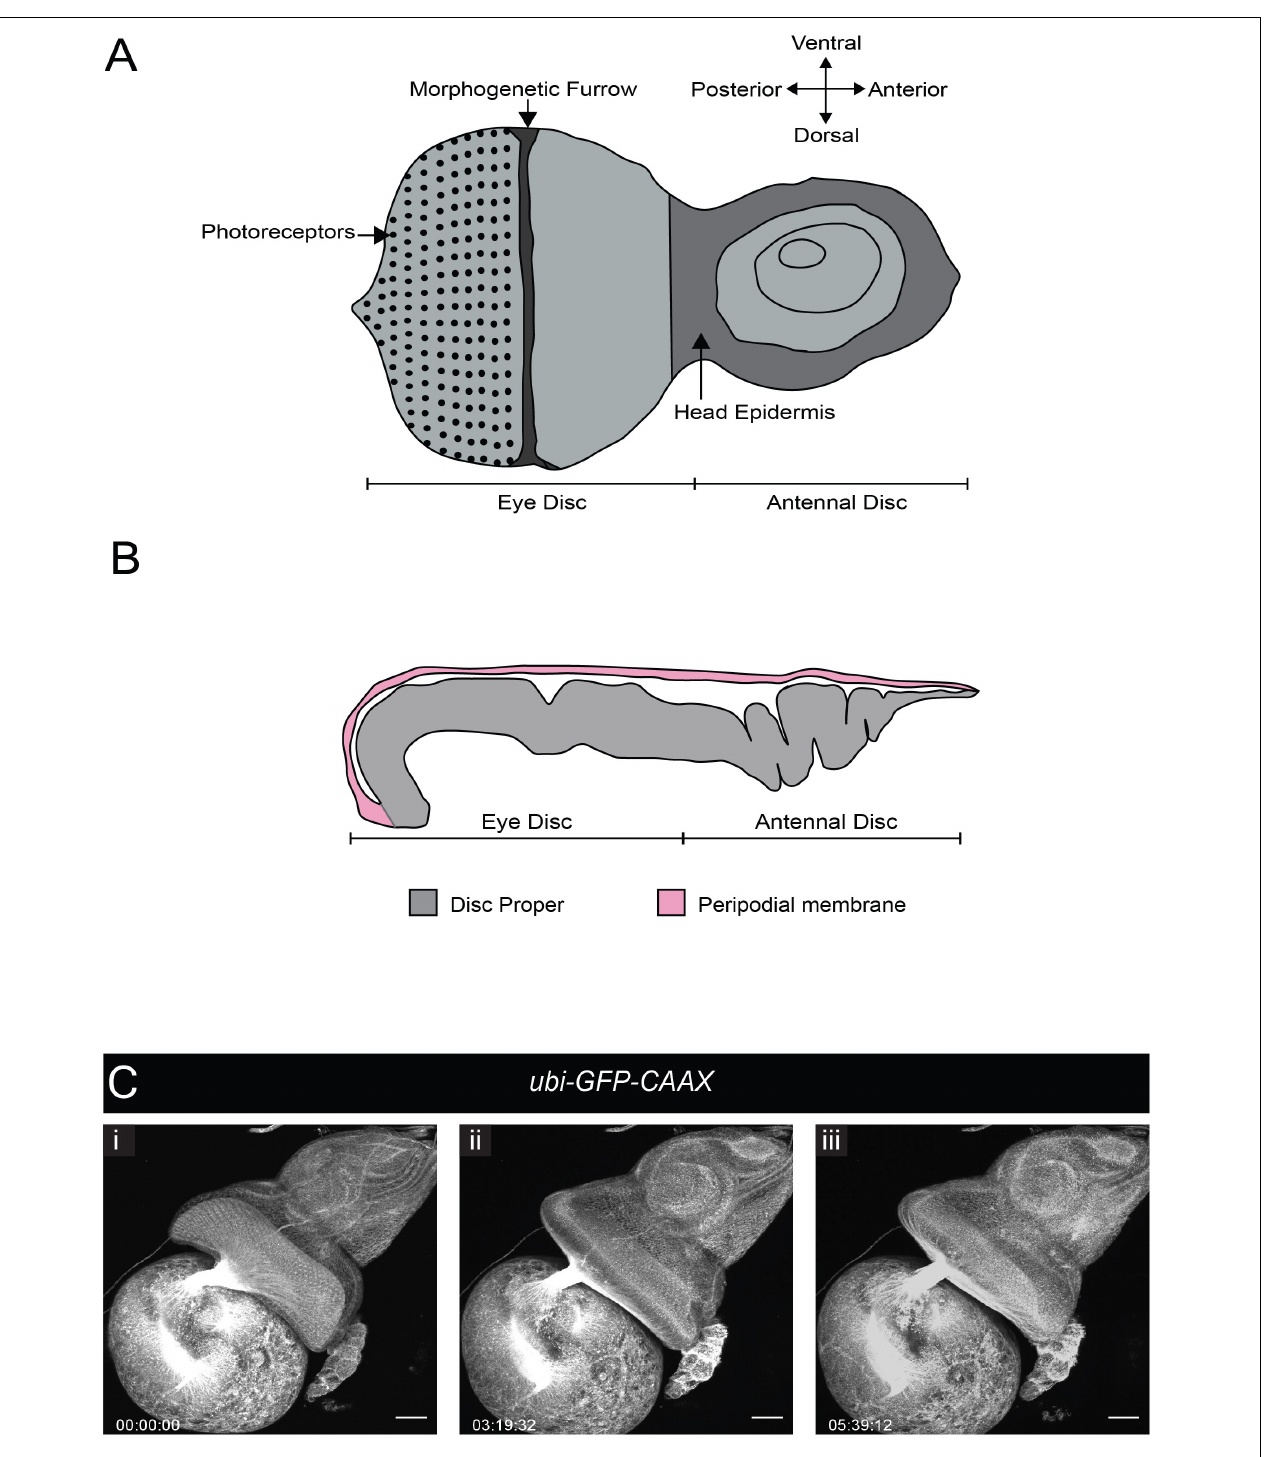
FIGURE 4 | Eye-antennal disc structure and disc eversion. (A) Schematic of an L3 eye-antennal disc. (B) Cross-section of the eye-antennal disc. The columnar epithelium of the disc proper at the anterior end (antennal side) is folded whereas that of the eye disc is stretched and convex in shape. The thin peripodial membrane sits above and is continuous with the disc proper which constitutes the eye disc and the antennal disc. (C) A time-series extracted from Movie 8 (maximum intensity projection) of a cultured ubi-GFP-CAAX eye-antennal disc-brain complex (wL3) showing the eye-antennal disc undergoing eversion. Timescale displayed as hr:mm:ss, scale bar = 40 µ